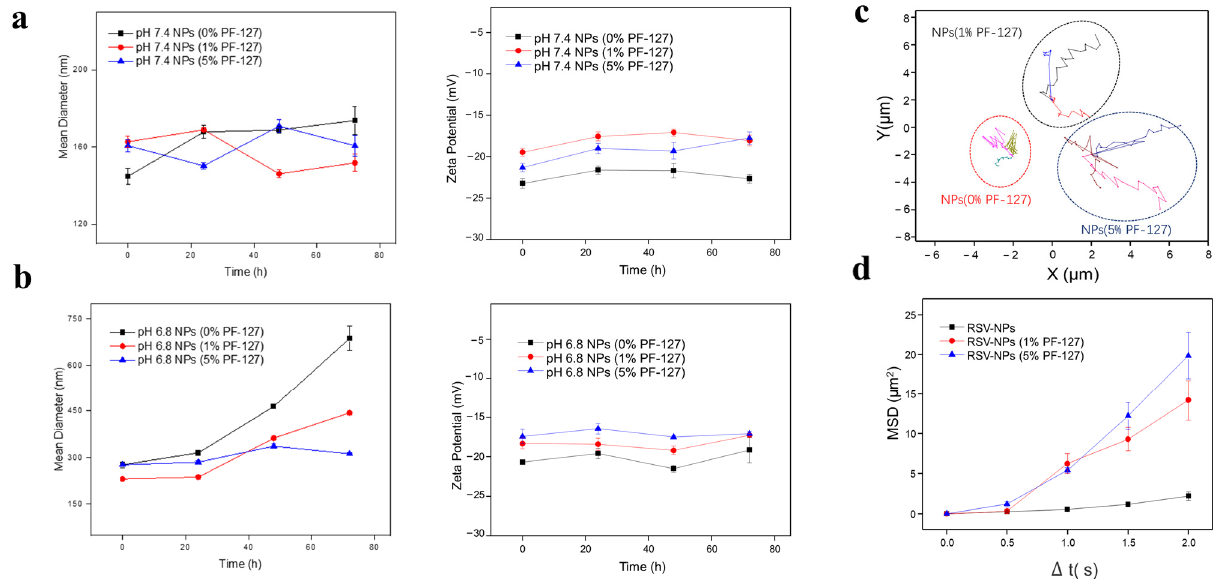
Figure 2. Stability and mucus penetration of NPs. Variations of hydrodynamic diameters and zeta potential of NPs during incubation in simulated intestinal fluid ( a ) and simulated colonic fluid ( b ) for 3 days. ( c ) Representative motion trajectories and ( d ) average MSD of various NPs in the mucus-simulating hydrogel. Data are expressed as means ± S.E.M, n = 3.